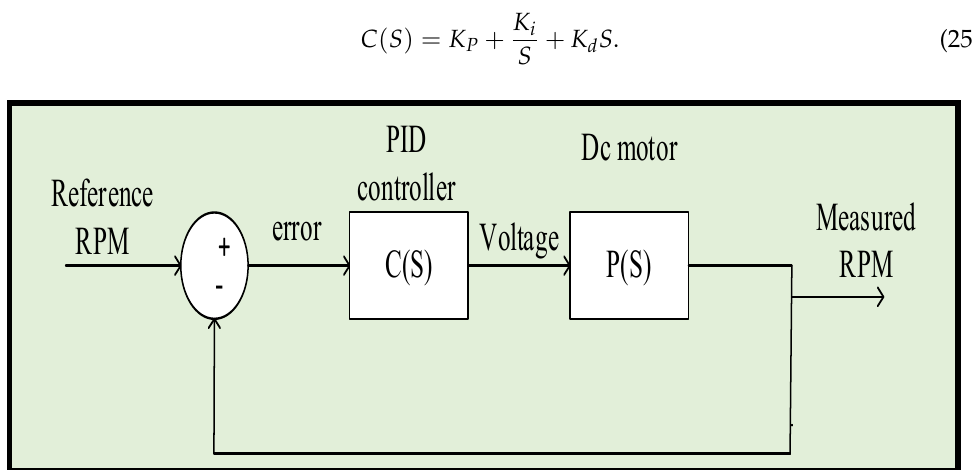
Figure 4. DC motor speed control using PID controller.